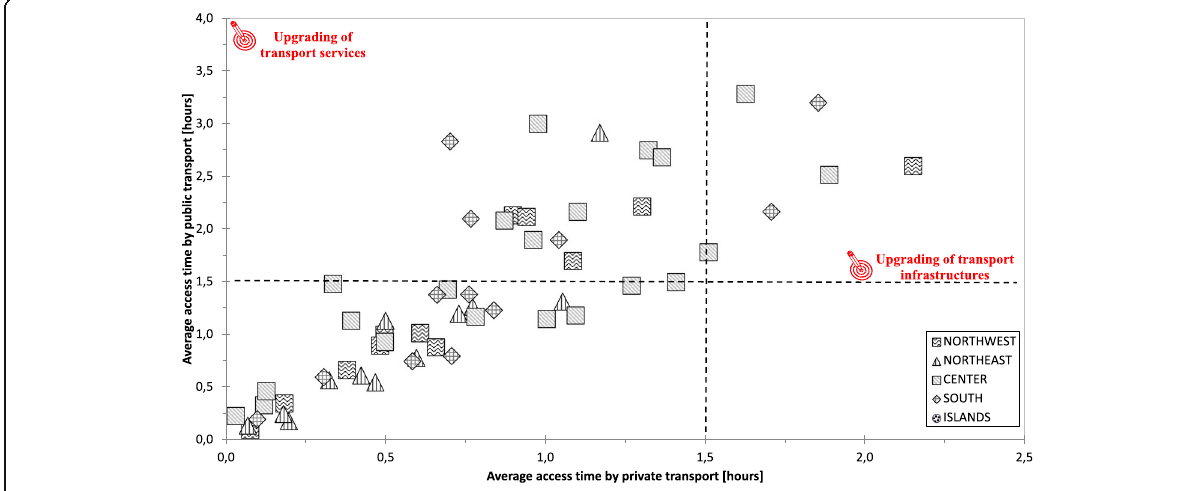
Fig. 11 AG diagram (from the main national railway stations)